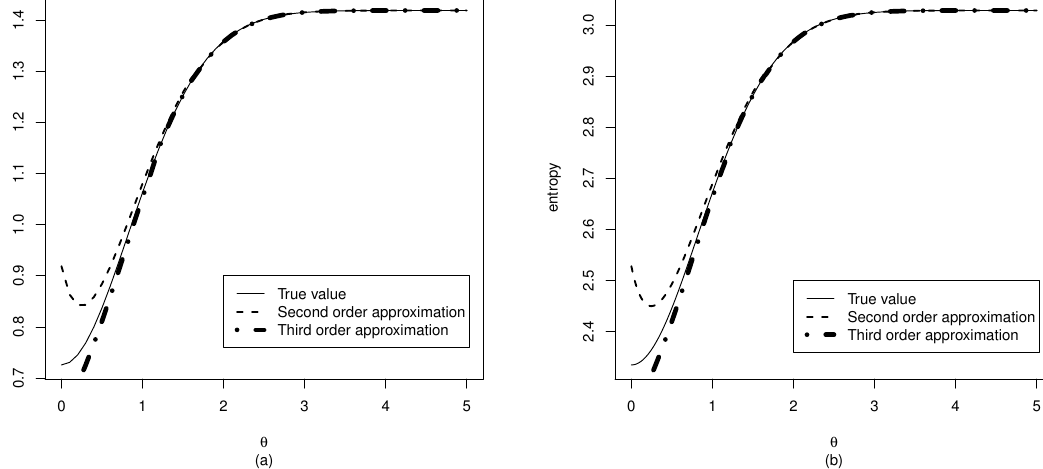
Figure 2. Entropy values for a range of values of θ = µ